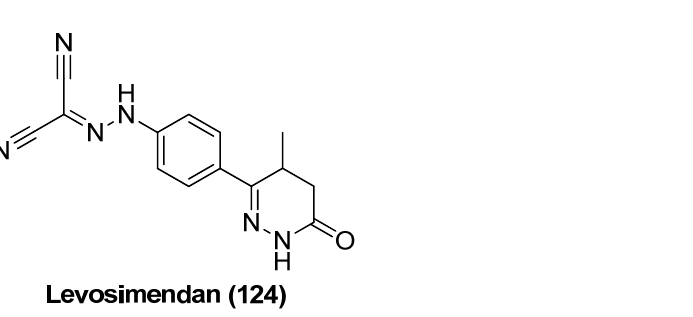
Figure 30. Levosimendan (124) is a LPA identified from FDA-approved compound